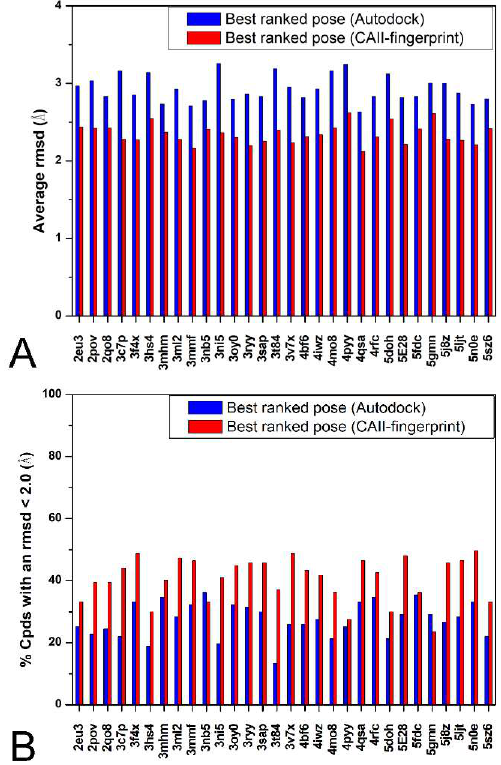
Figure 2. Comparison between the results obtained using the Autodock4 scoring function and the Tanimoto similarity index (Tc-IFP). For each CAII protein, the aRMSD ( A ) and the percentage of poses with a RMSD less than 2.0 Å ( B ) are reported for both the best-ranked pose using the Autodock4 scoring function (blue) and using the Tc-IFP function (red).